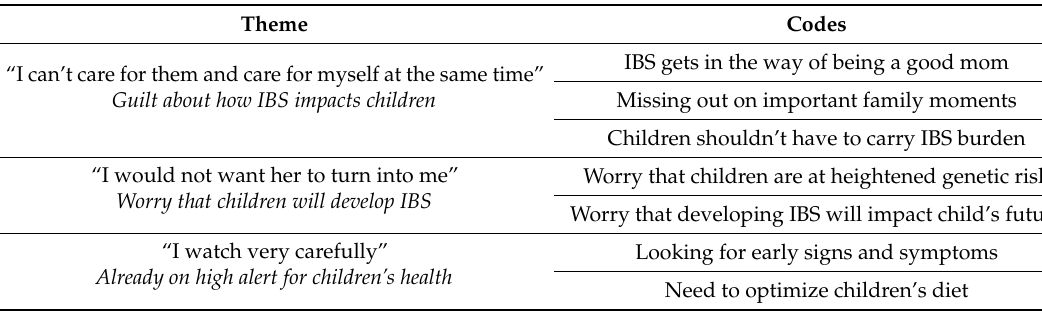
Table 1. Themes and